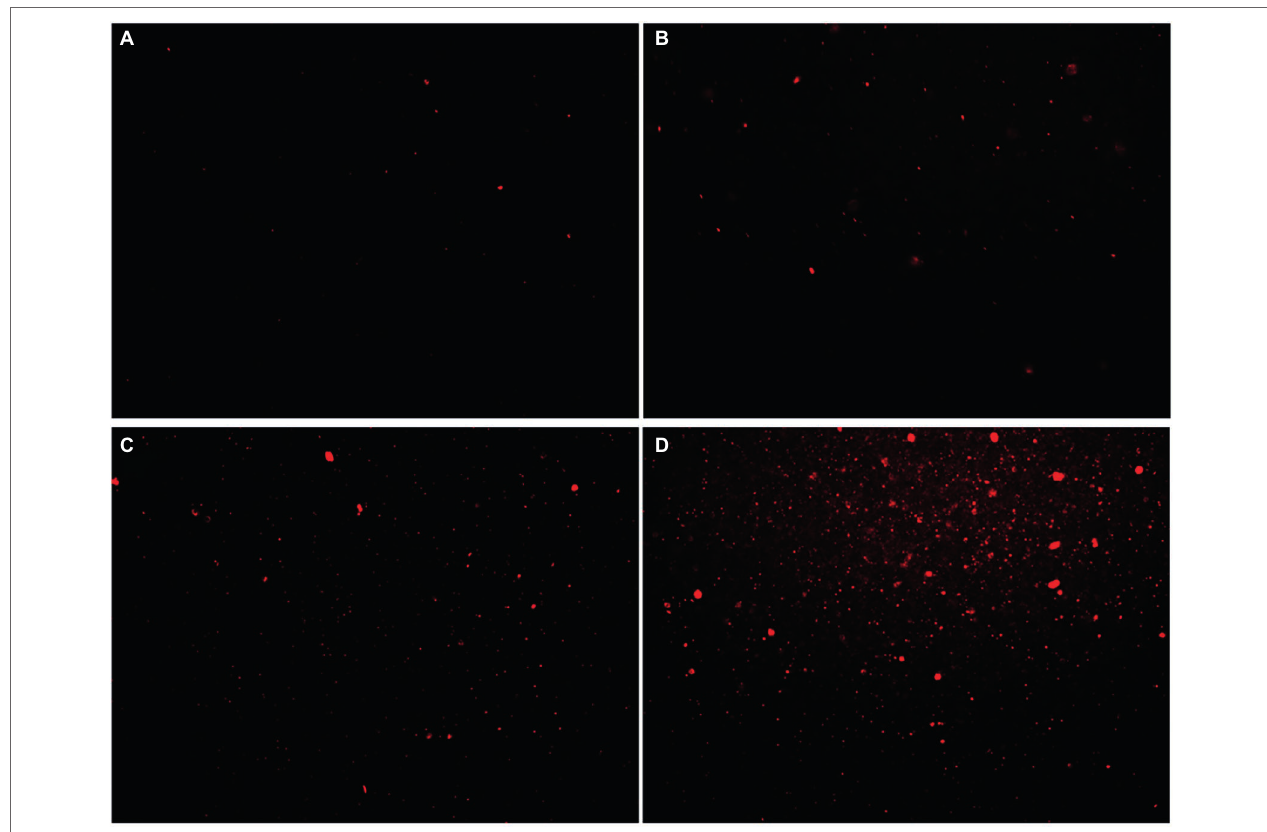
FIGURE 5 | Effects of moringin on cell membrane integrity of Listeria monocytogenes by inverted fluorescence microscope. (A) Untreated Listeria monocytogenes . (B) Listeria monocytogenes treated with moringin at 1/2 MIC. (C) Listeria monocytogenes treated with moringin at 1 MIC. (D) Listeria monocytogenes treated with moringin at 2 MIC.